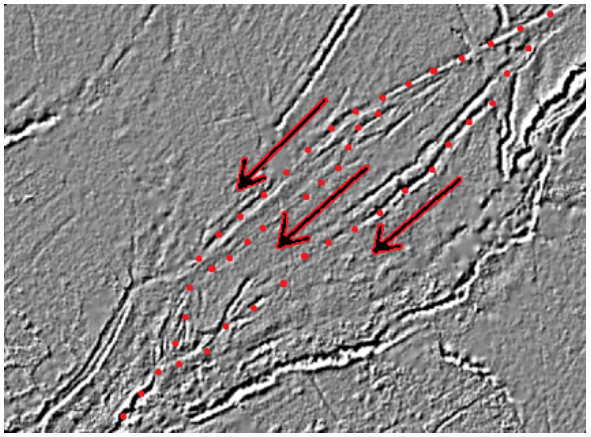
Figure 5. Branches of a pathway crossing hillside Second Military Mapping Survey performed between the years 1836-1852, with parts of erosion cut not visible in terrain at the present time – because of later terrain modification. This reconstruction of the terrain shape and its size confirm the geological origin of the cut and its connection with water erosion occurring on the hillside over the village of M ě lník. This erosion cut turns to the west instead of the south (aspect image, Fig. 3), which was assumed in the hypothesis about theprehistoric pathway. The cut is still connected with a similar brook bed that springs south from village of M ě lník. The erosion cut has been successively damaged since the 19th century by agricultural activities, as its main parts were used for the construction of a motorway from Moštice to M ě lník in 20th century.